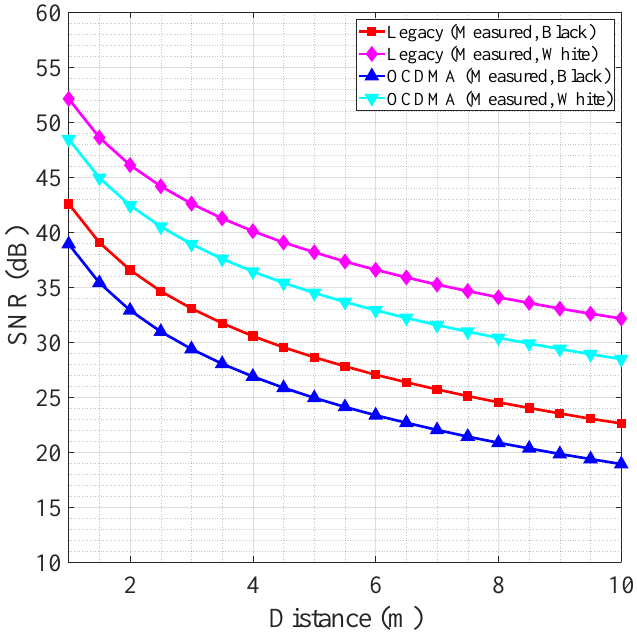
Figure 7. Measured minimum received signal strength every 0.5m from 1m to